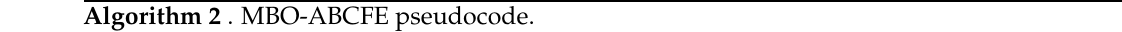
Algorithm 2 . MBO-ABCFE